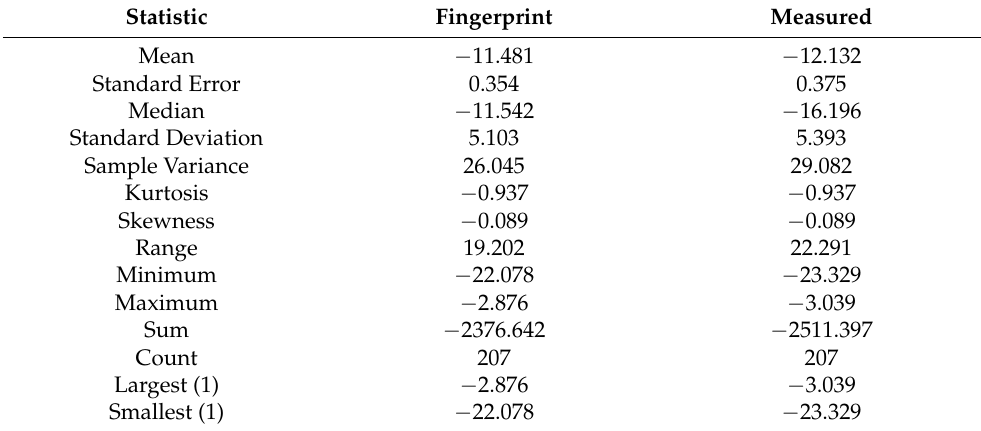
Table 14. Sub-region 2: Descriptive statistics comparison between fingerprint and measured FRA profiles.